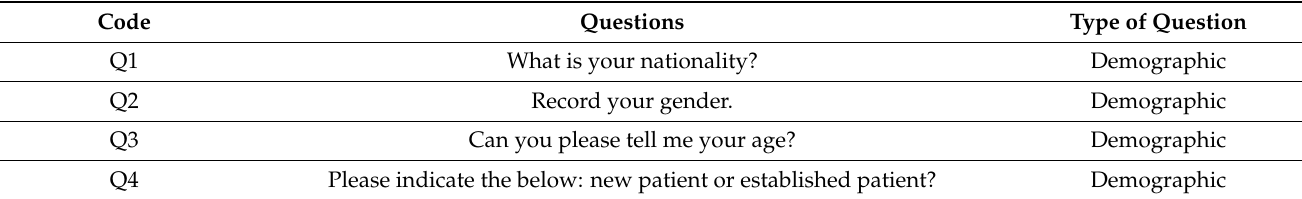
Table 1. Demographic questions in the survey.